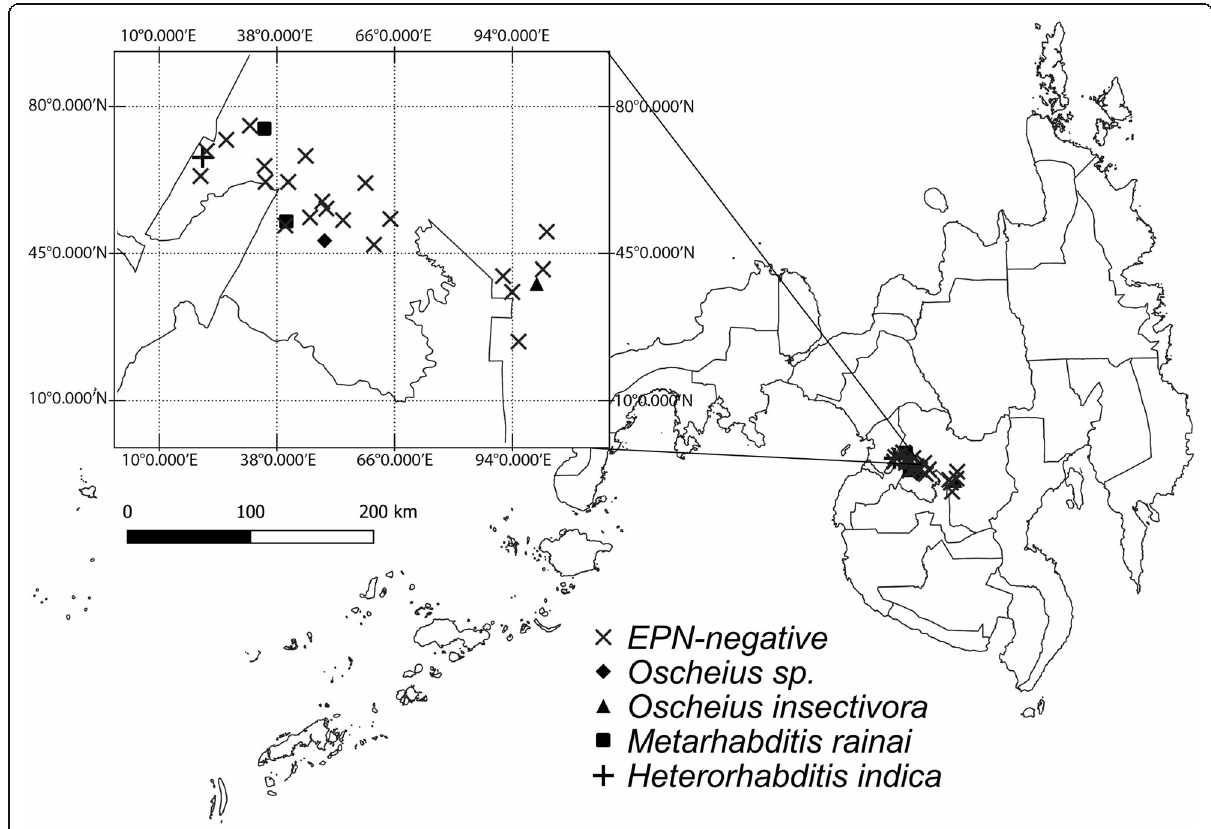
Fig. 1 Map of Mindanao island showing the sampling sites of the entomopathogenic and facultative necromenic nematodes in the province of Cotabato, the Philippines. The prevalence and distribution of Heterorhabditis indica ( + ), Metarhabditis rainai ( ■ ), Oscheius insectivora ( ▲ ), and Oscheius sp. ( ♦ ) and sampling sites without nematode recovery were also indicated (x) (created using QGIS version 3.10.1 A